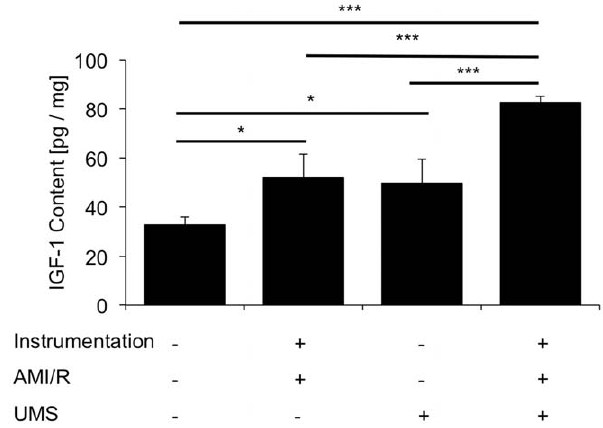
Figure 8. Myocardial protein concentration of IGF-1 after UMS. Insulin-like growth factor 1 (IGF-1) was measured with a quantitative ELISA. UMS application not only increased IGF-1 content in control hearts, but also demonstrated a significant upregulation of IGF-1 on top of acute myocardial infarction and reperfusion (AMI/R).